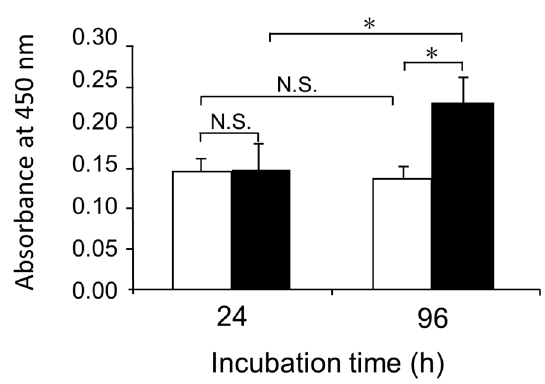
Figure 5. E ff ect of mixture of Pro-Hyp and Hyp-Gly on the growth of fibroblasts on collagen gel in the presence of 10% FBS-1 free from LMW hydroxyprolyl peptides; ( (cid:3) ), control; ( (cid:4) ), medium containing Pro-Hyp and Hyp-Gly at 100 µ M. Data are shown as mean ± SD ( n = 5). Asterisks indicate significant di ff erences ( p < 0.05, Tukey’s test). N.S. indicates results that are not significantly di ff